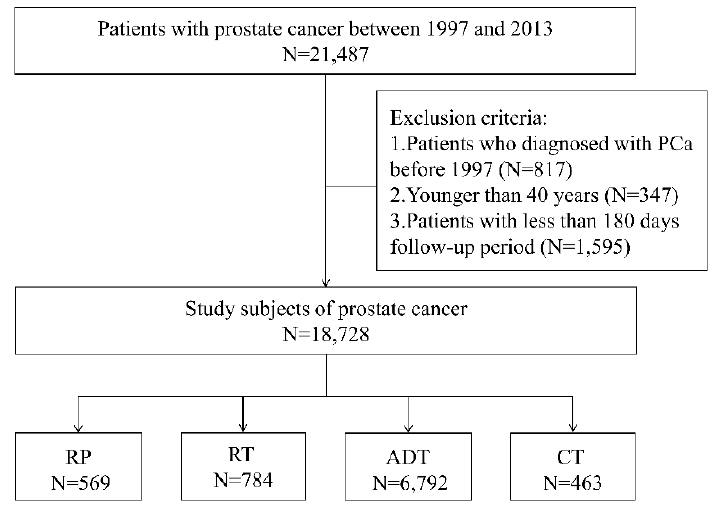
Figure 1. Study flowchart. RP, radical prostatectomy; RT, radiation therapy; ADT, androgen depriva- tion therapy; CT, chemotherapy.